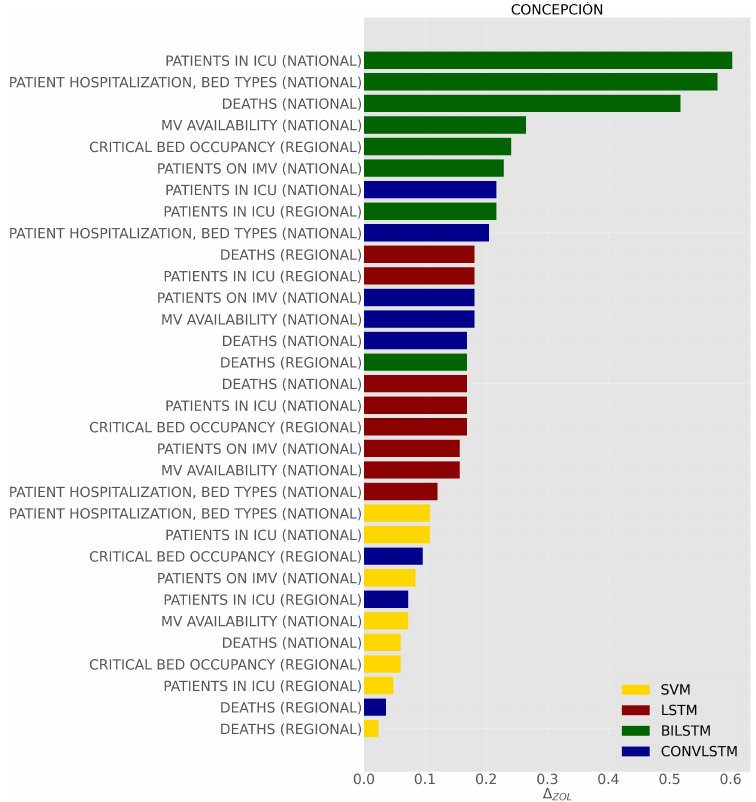
Figure 10. This bar plot shows the relative importance of the features in terms of zero-one-loss error in predicting risk